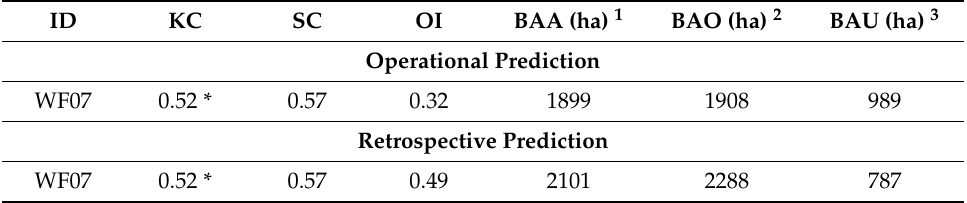
Table 5. Statistical evaluation of IRIS’s operational and retrospective wildfire spread predictions for the Kontodespoti wildfire (WF07). Values of KC followed by * denote statistical significance (Z-test) at p ≤ 0.10. ID KC SC OI BAA (ha) 1 BAO (ha) 2 BAU (ha)